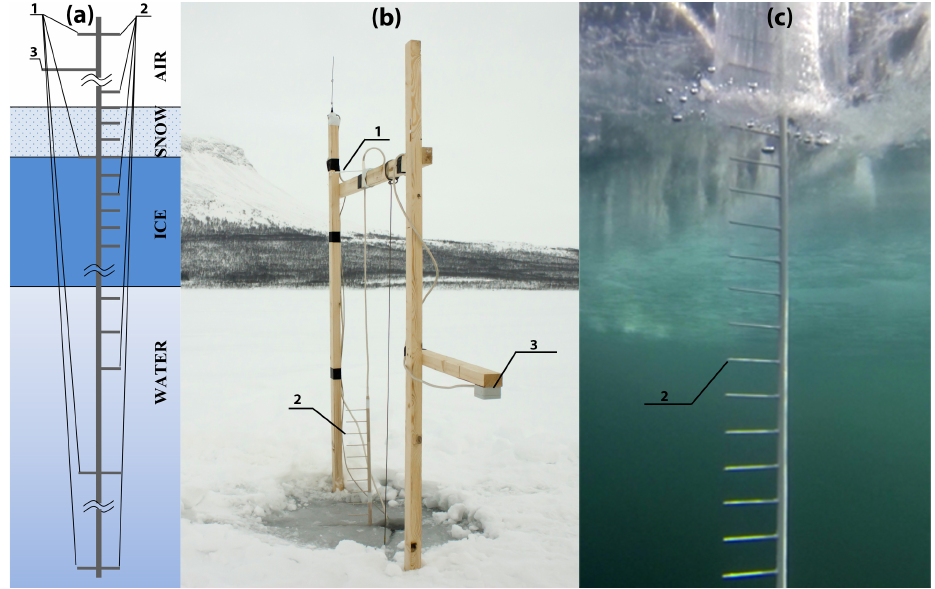
Figure 2. ( a ) Measuring system of the ASLIM: 1—light sensors, 2—temperature sensors, 3—snow thick- ness sensor; ( b , c ) photos of above-water and underwater parts of the measuring system,